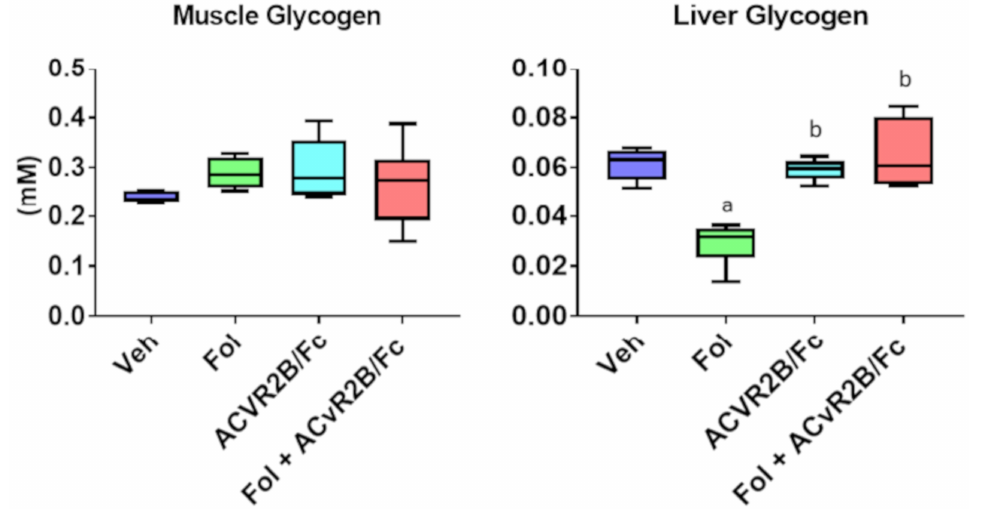
Figure 9. Muscle and liver glycogen levels. Quantification was performed on homogenized tissue extracts using a commercial colorometric assay. Significance di ff erences include p -values < 0.05 for a vs. Veh, b vs. Folfiri, c vs. ACVR2B / Fc.